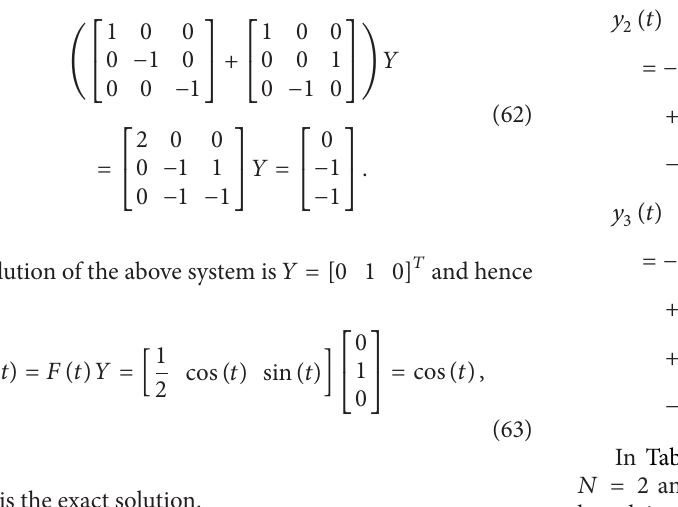
̂𝑀 = 3, 4, 5 of Example